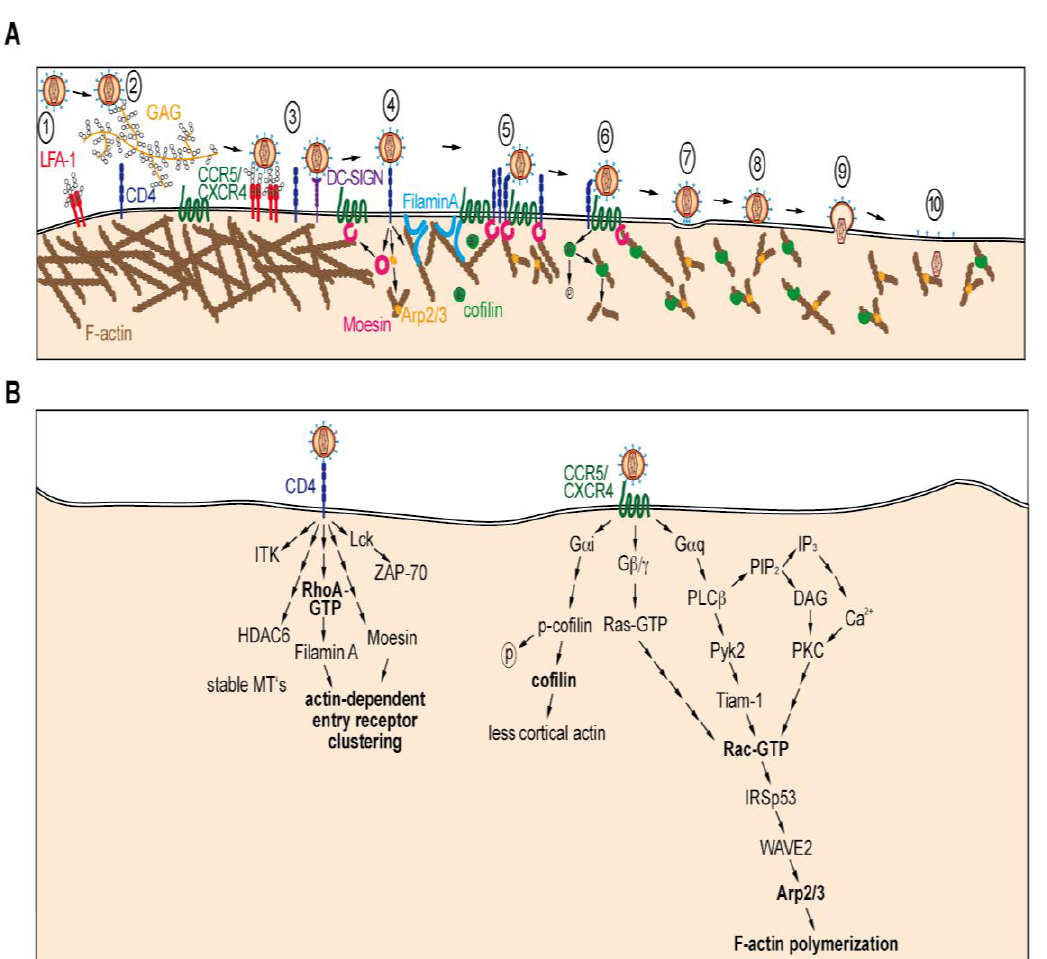
Figure 1. Proposed signaling pathway to the actin cytoskeleton during HIV-1 entry in